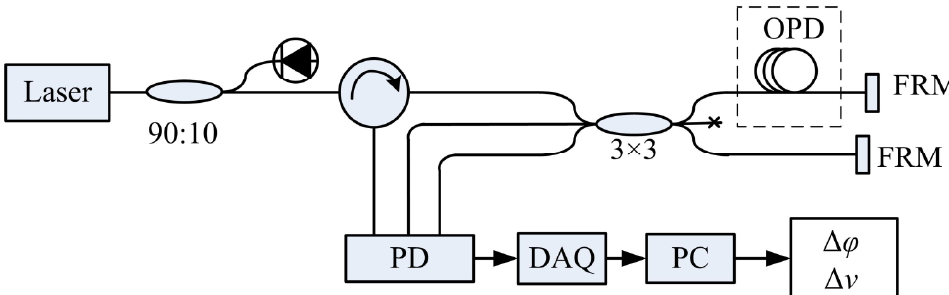
Figure 1. Experimental setup of the phase demodulation system based on Michelson interferometer. PD: photoelectric detector; DAQ: data acquisition; PC: personal computer.